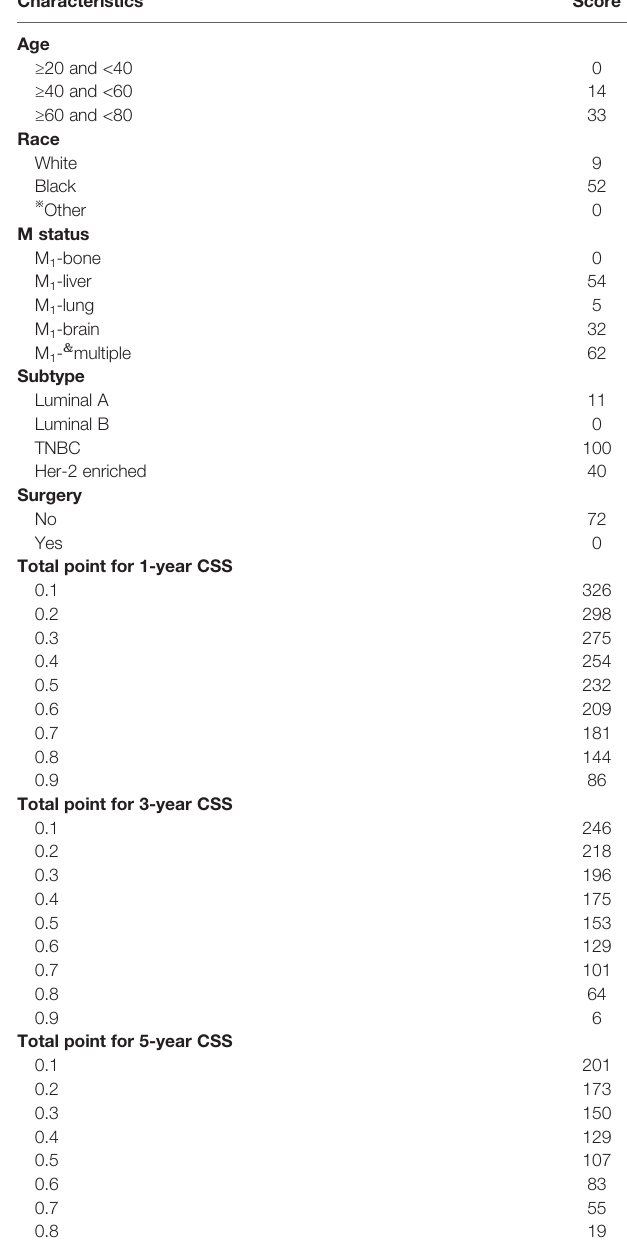
TABLE 4 | The speci fi c value of clinicopathological factors in the nomogram in the training cohort.